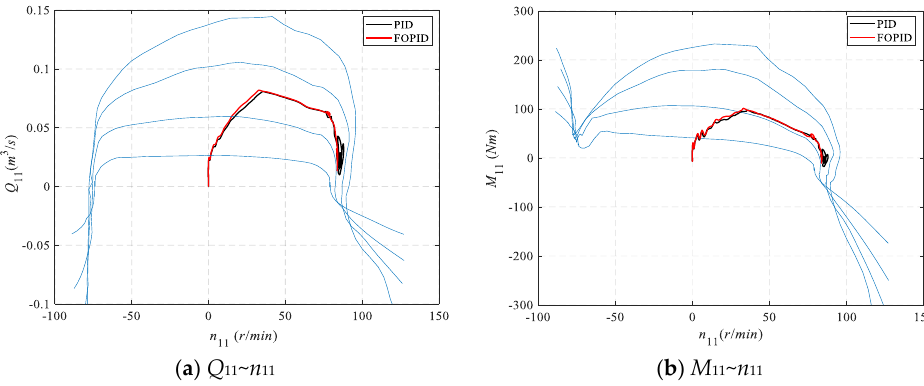
Figure 16. The dynamic curves of the actual working water head of the two PSUs.